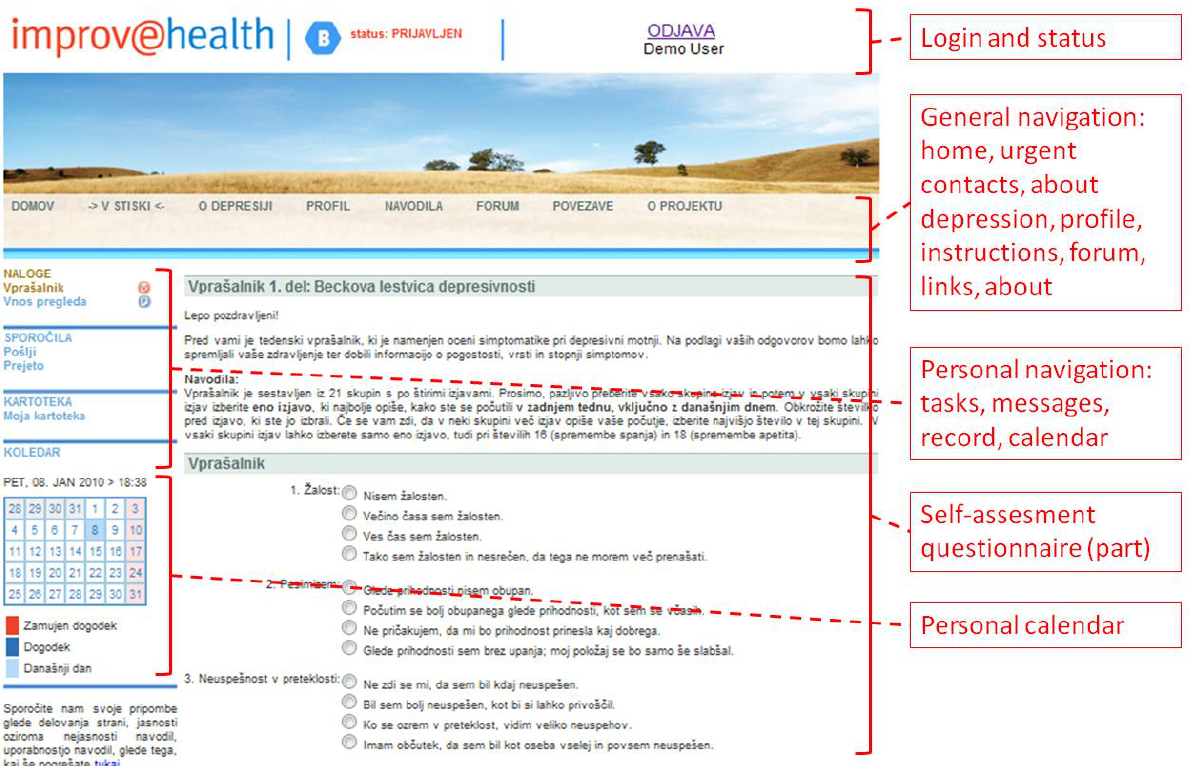
Figure 2. Screenshot of “Improvehealth.eu” in which a patient is submitting a questionnaire (the red semibrackets indicate particular modules, explained in boxes on the right hand